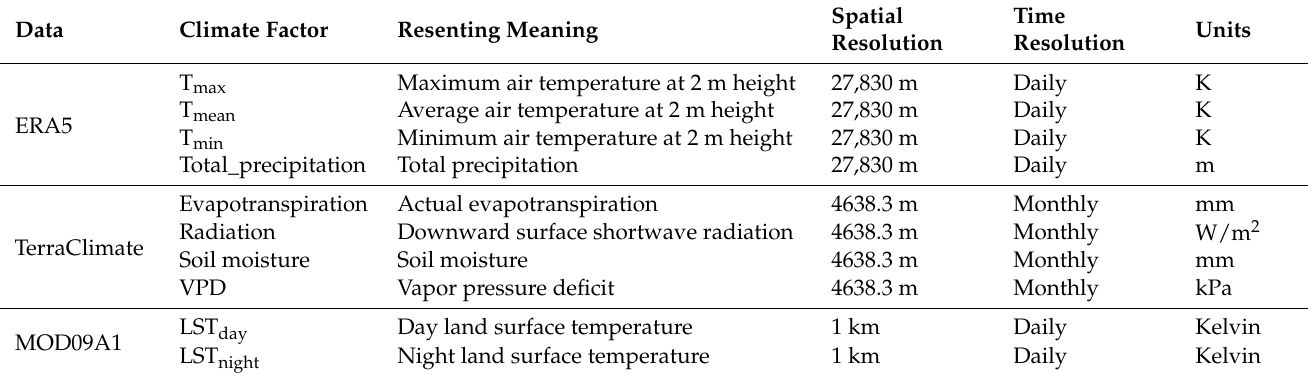
Table 2. Climate